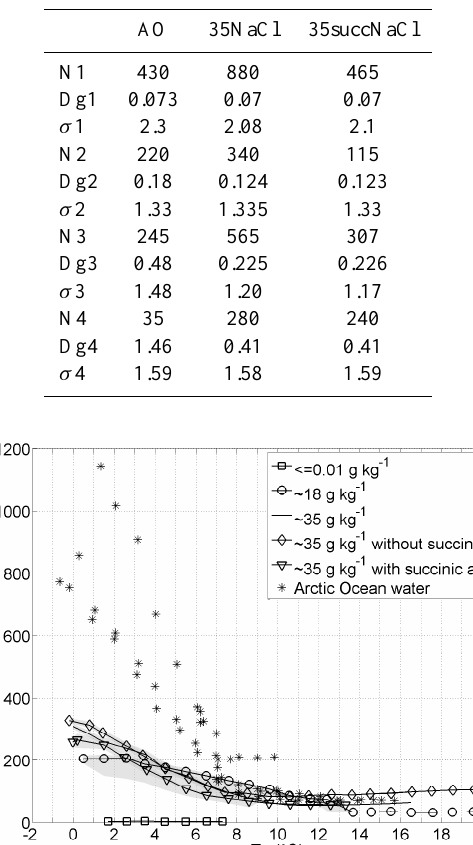
Table 1. Parameters for fitted lognormal aerosol number size distri- butions with Nx as the number concentration (cm − 3 ), Dgx as the geometric diameter (µm) and σ x as the standard deviation for the different modes and waters: Arctic Ocean water (AO), NaCl water